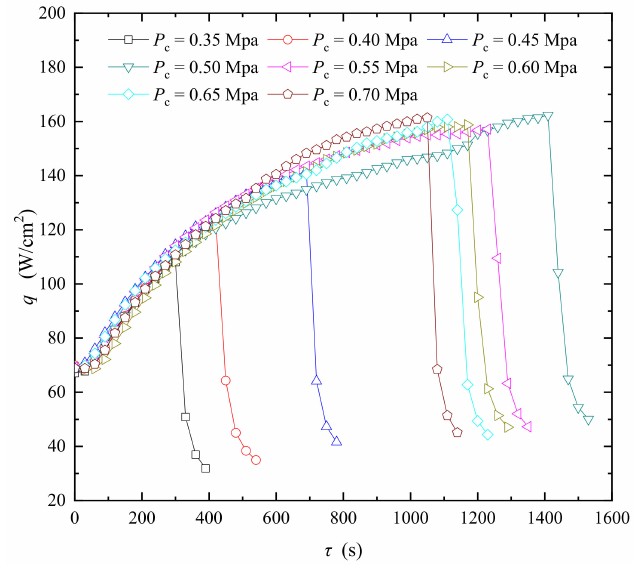
Figure 10. Curves of heat flux with time under different refrigerant charges.